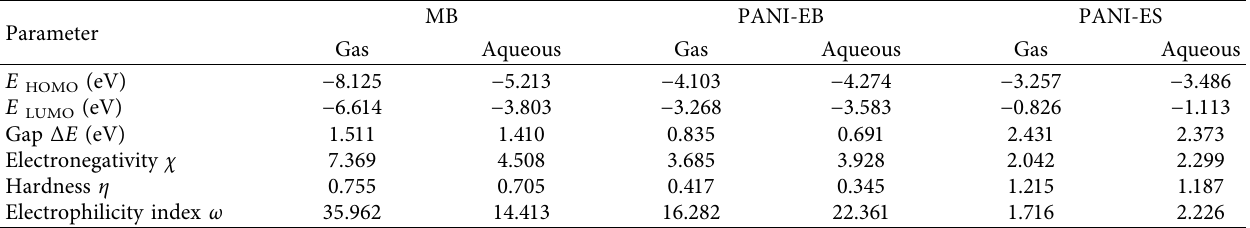
Table 2: Quantum chemical descriptors of the studied MB/PANI-EB and MB/PANI-ES. Parameter